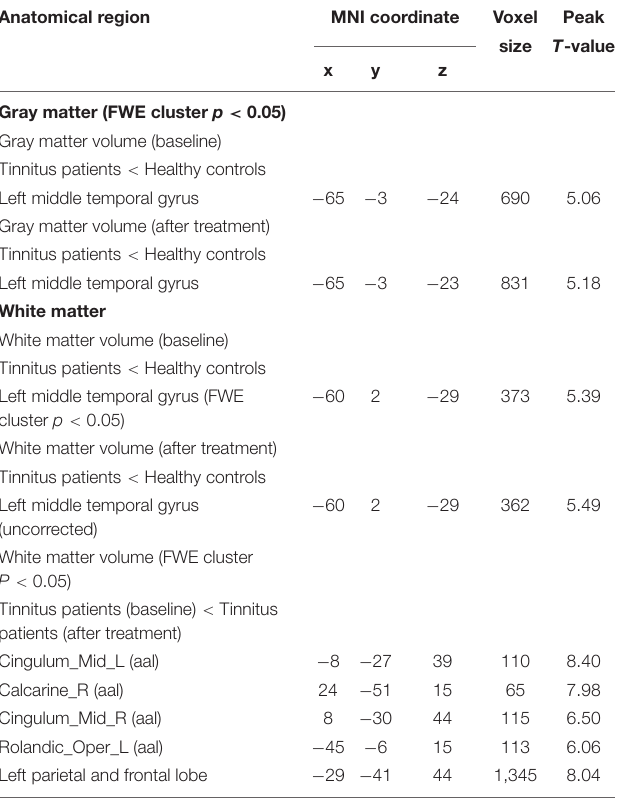
TABLE 2 | Difference in gray/white matter volume between the tinnitus patients and healthy controls and between patients before and after sound therapy. Anatomical region MNI coordinate Voxel Peak size T -value x y